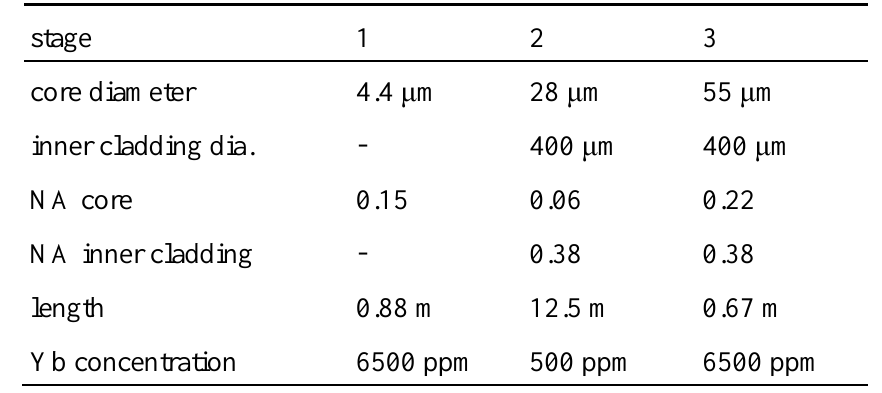
Table 1. Fiber properties of the three stages of the fiber amplifier. NA is the numerical